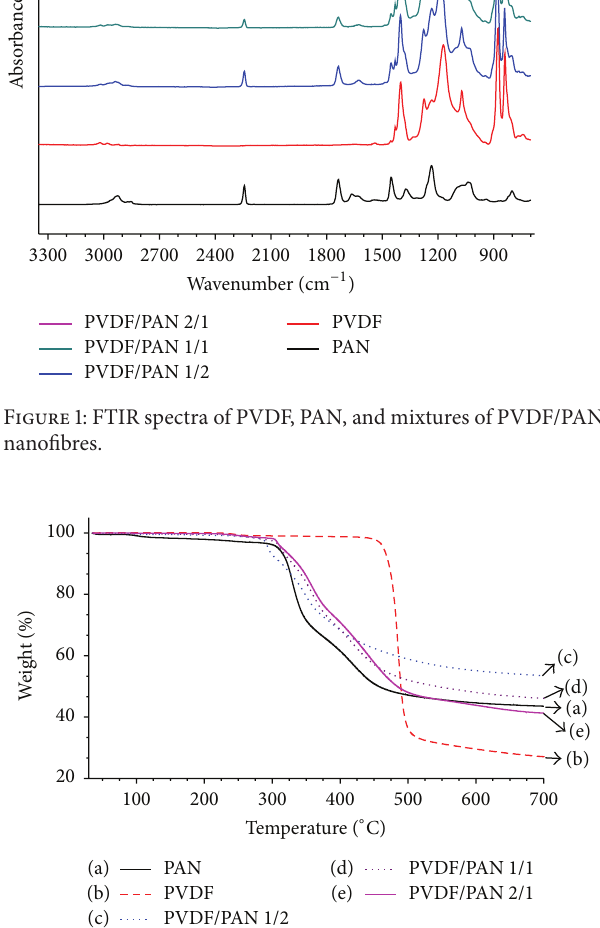
Figure 2: TGA thermograms for PVDF, PAN, and mixtures of PVDF/PAN nanofibres.